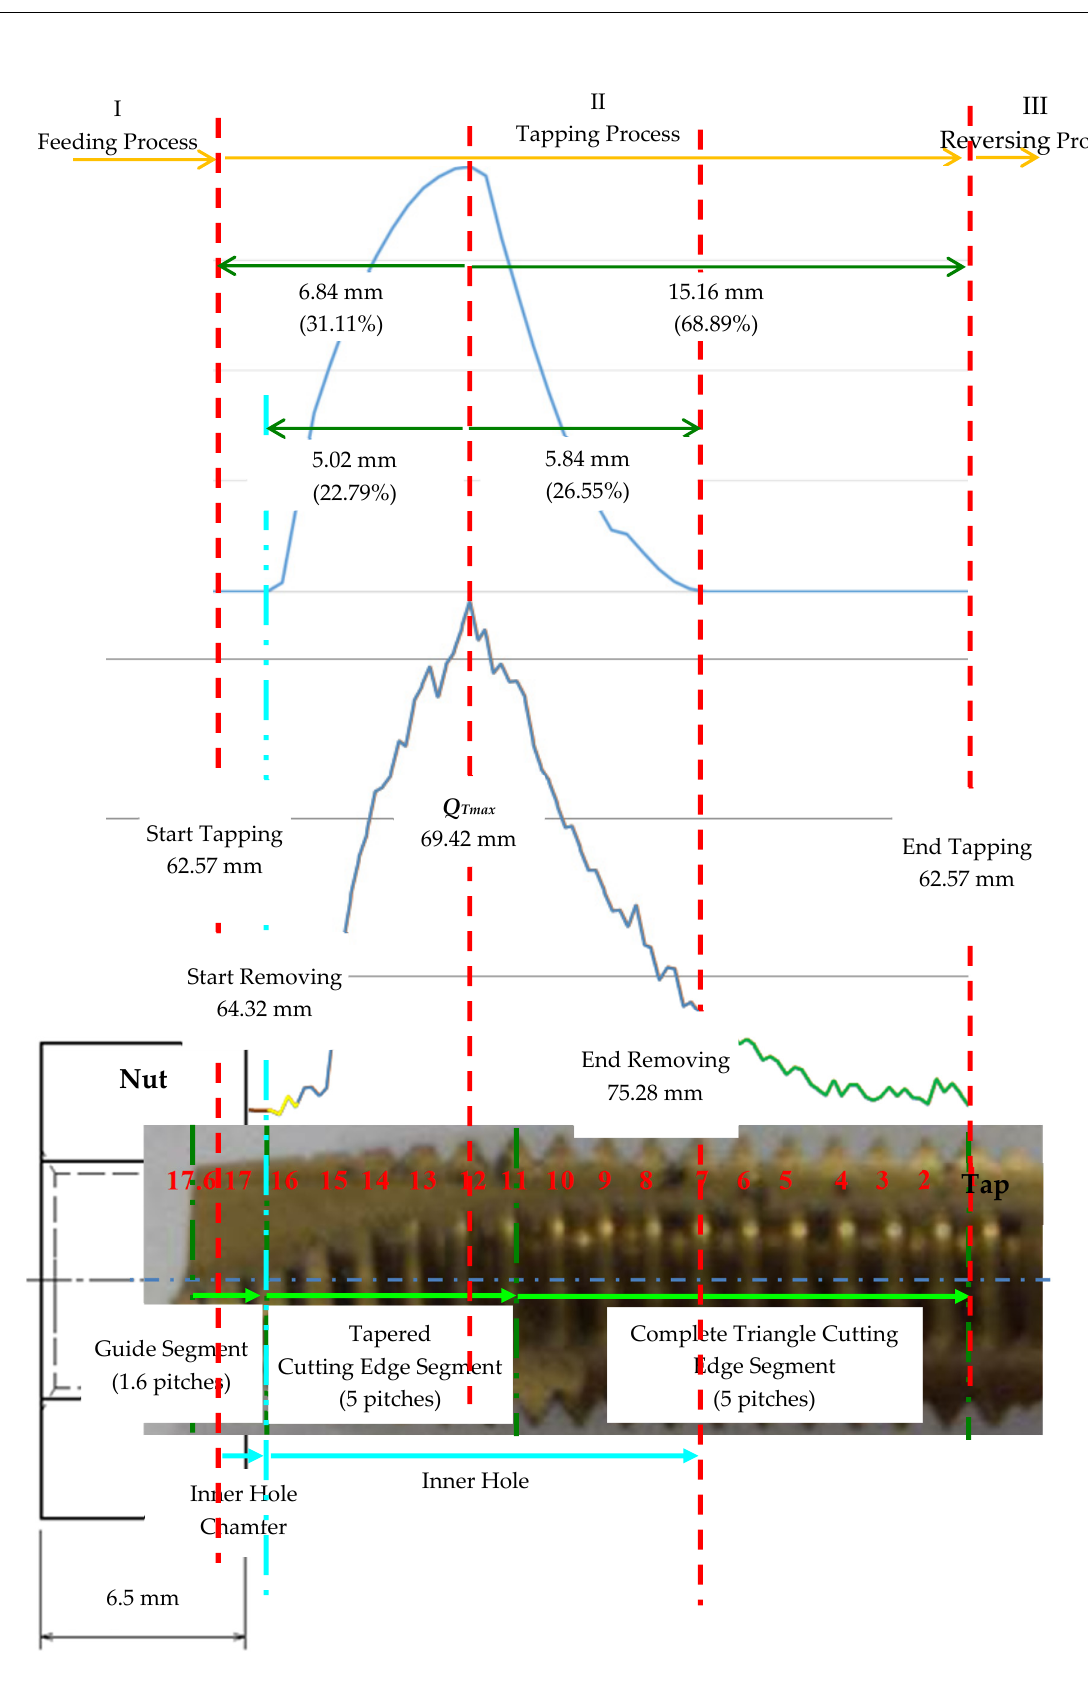
Figure 5. The characteristics of the material removal rate curve and the measured tapping torque.